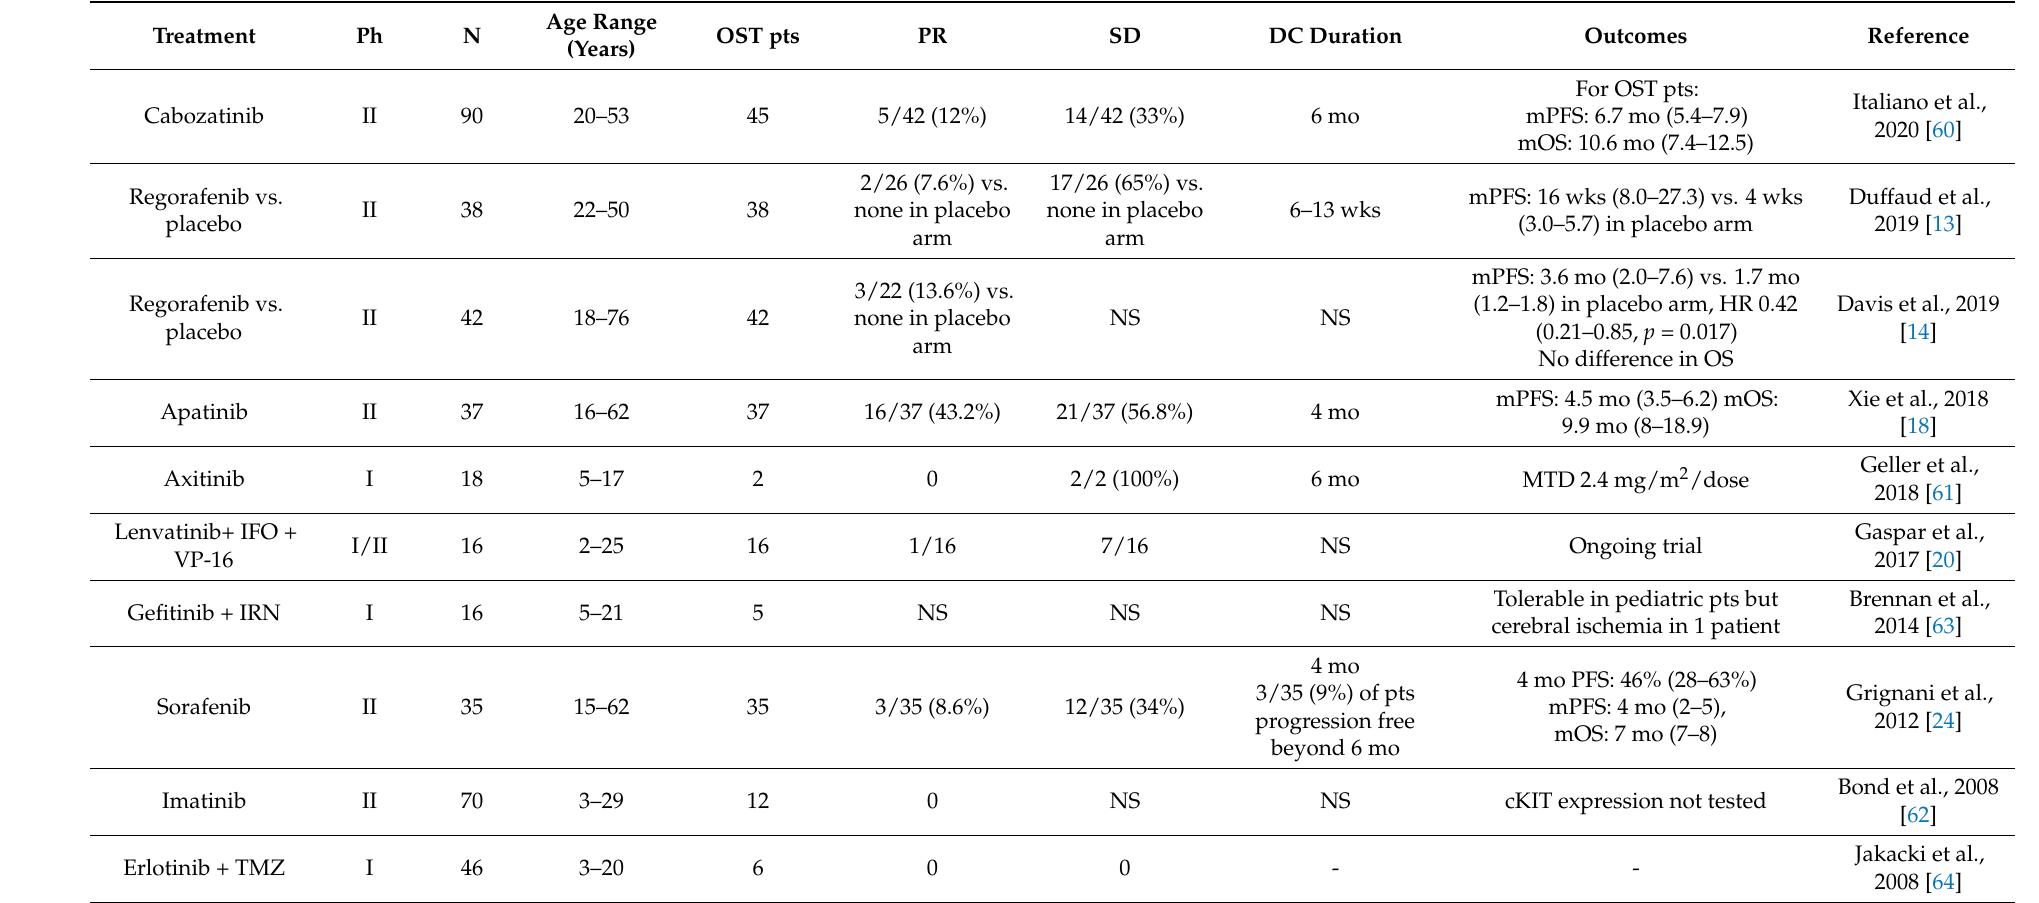
Table 2. Tyrosine Kinase Inhibitors (10